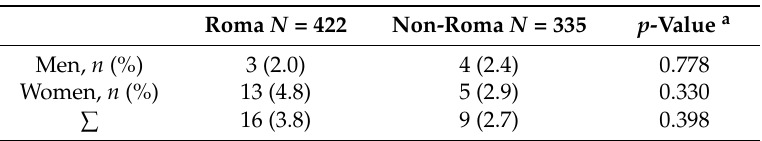
Table 4. Occurrence of Chlamydia trachomatis infection in the population living in Roma settlements and the non-Roma population in eastern